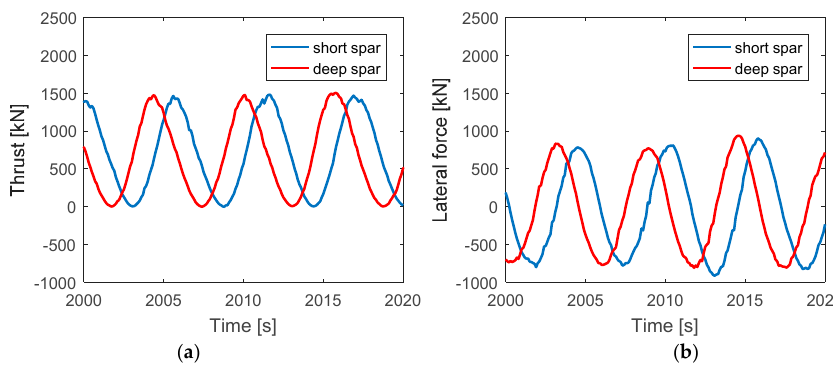
Figure 6. Comparison of time series in 2P loading for short spar and deep spar VAWTs under LC3 with U w = 14 m/s, H s = 3.62 m, T p = 10.29 s: ( a ) Thrust; ( b ) Lateral force.